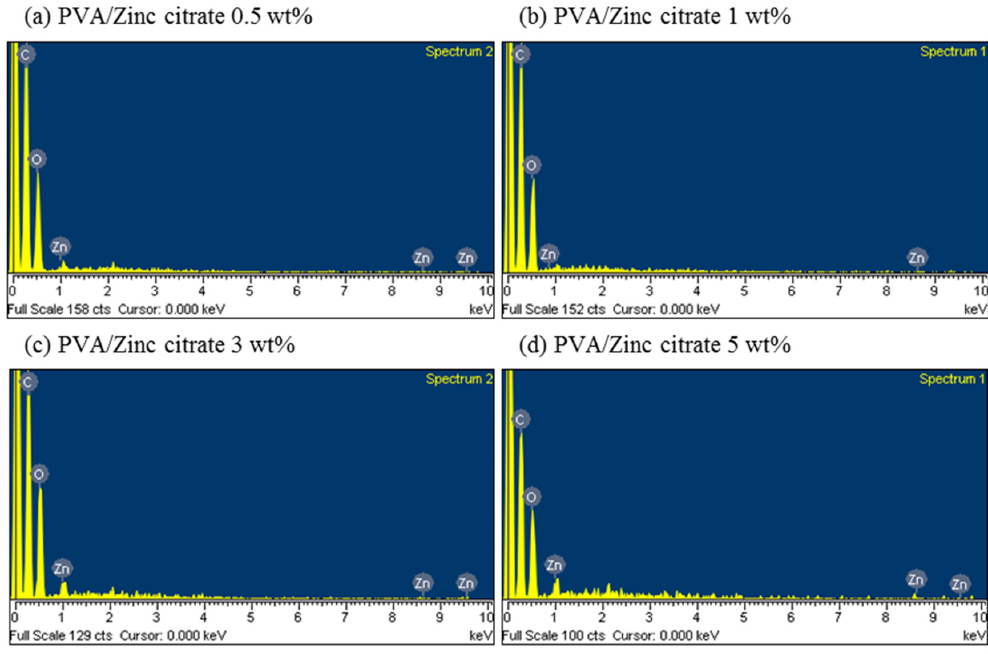
Figure 6. EDS charts of PVA/zinc citrate nanofiber mats that contain ( a ) 0 wt %; ( b ) 0.5 wt %; ( c ) 1 wt %; ( d ) 3 wt %; and ( e ) 5 wt % zinc citrate. Table 2. Element content of PVA/zinc citrate nanofiber mats as related to various amounts of zinc citrate. Element Zinc Citrate Content (wt